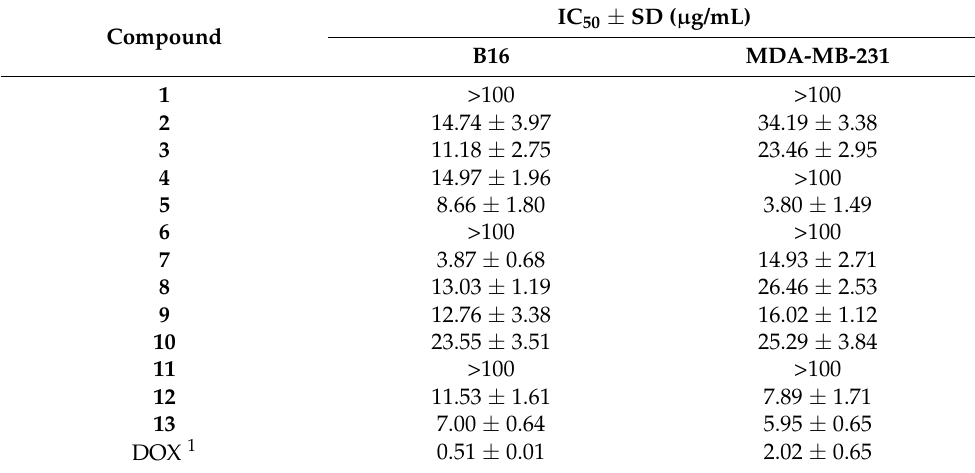
Table 2. Cytotoxicities of flavonoids 1 – 13 from Murraya tetramera .